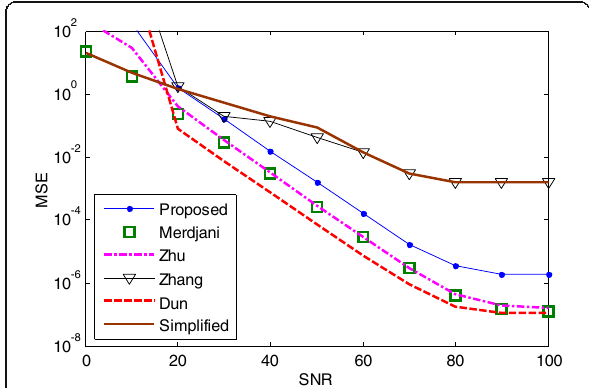
Fig. 3 MSE vs. SNR of different frequency estimators for single-tone sinusoidal input. There were averages of 10,000 runs for each SNR